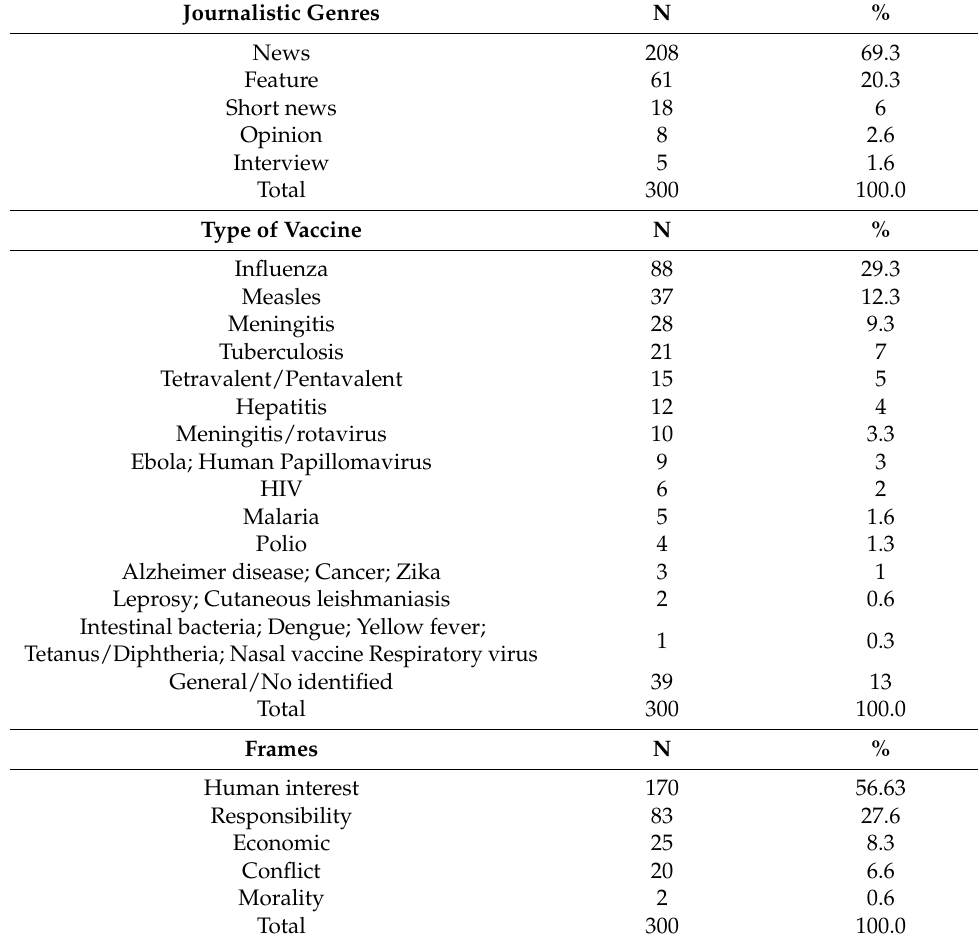
Table 1. Characteristics of the study